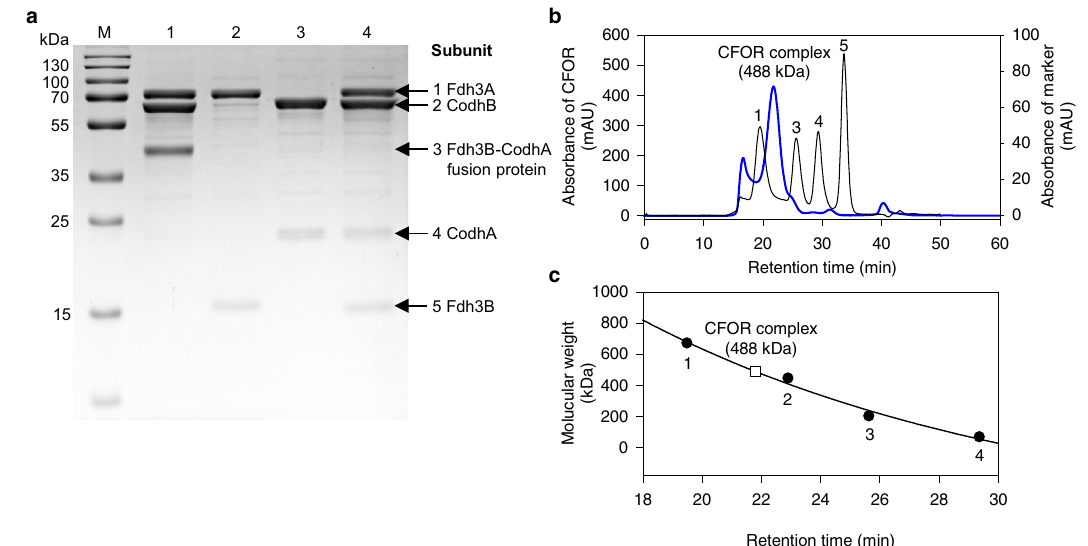
Fig. 2 Puri fi cation and identi fi cation of the synthetic CFOR complex from T. onnurineus BCF13. a Strep-tag puri fi ed CFOR complex, Fdh3AB, and CodhAB sub-complex were loaded to a 12% acrylamide gel and stained with Coomassie Brilliant Blue after gel running. Subunits are indicated with a black arrow. M , molecular mass standards; lane 1 , CFOR (6 ug); lane 2 , Fdh3AB (2.2 ug); lane 3 , CodhAB (3.8 ug); lane 4 , Fdh3AB (2.2 ug) + CodhAB (3.8 ug). b The af fi nity column puri fi ed CFOR complex (blue line), and standard marker (black line) were separated on a Superdex 200 10/300 GL column. A number on a standard peak indicates: 1. Thiroglobulin, 669 kDa; 2. Apoferritin, 443 kDa; 3. Beta-amylase, 200 kDa; 4. Albumin, 66 kDa; 5. Carbonic anhydrase, 29 kDa. c The retention time versus the logarithm of the molecular weight of the CFOR complex (open rectangle) and standard marker (closed circle) was plotted on the regression. Table 1 Speci fi c activities of CO oxidation, formate oxidation, and formate production from the puri fi ed CFOR, Fdh3AB, and CodhAB.